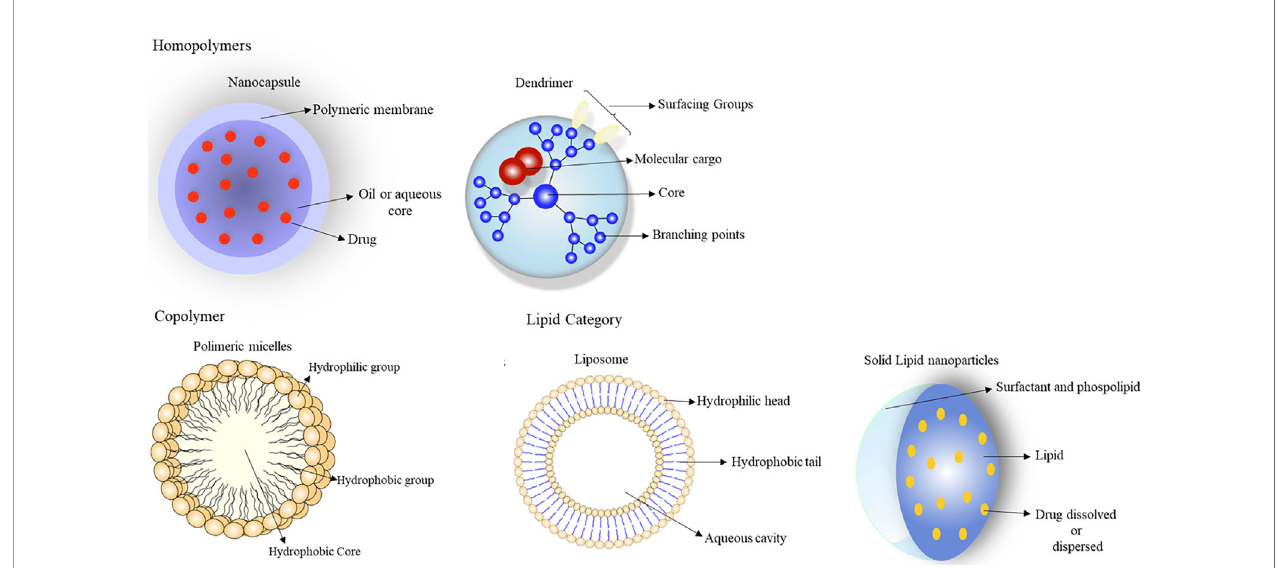
FIGURE 6 | These systems can be dividedinto two maingroups: organic and inorganiccarriers. Organic nanoparticles can be subdivided into: polymeric (homopolymers and copolymers) and lipids. Homopolymers include: nanospheres, nanocapsules, hydrogel, and dendrimers; copolymers are micelles and polymersomes. The lipid category comprises solid lipids, liposomes, and micelles, since metallicnanoparticles, fullerenes, carbon nanotubes, andceramicnanoparticles are inorganicnanoparticles. From: